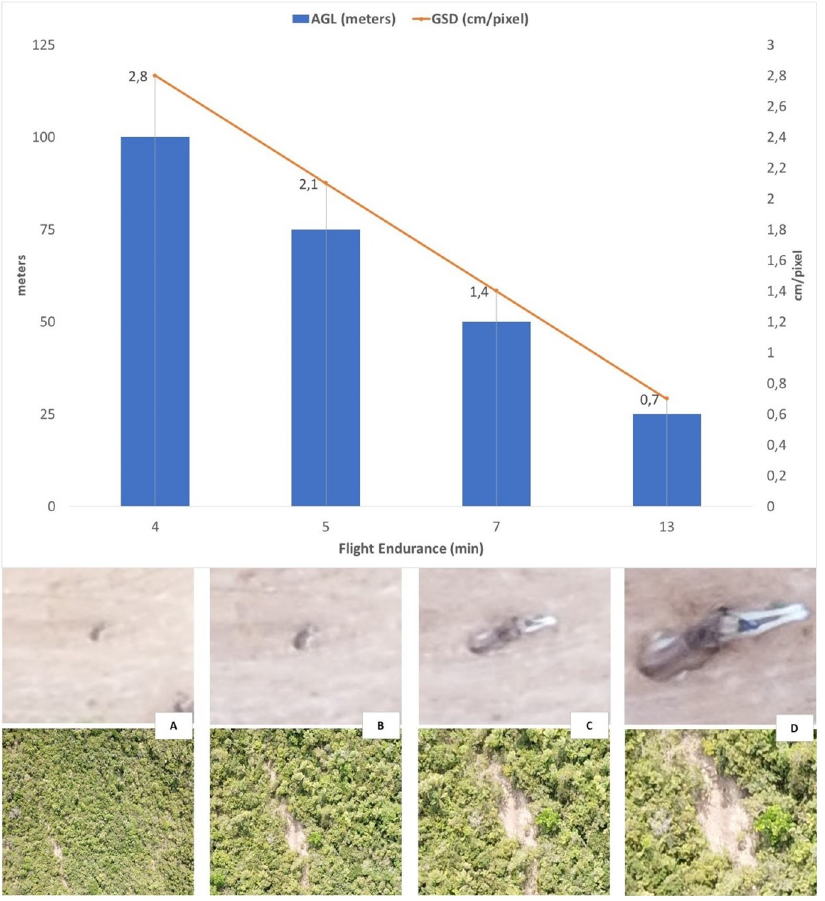
Fig 5. Comparison between Above Ground Level (AGL), Ground Sample Distance (GSD) and flight duration. Images with a 10x zoom of a dog and a deforestation spot at (a) 100 m; (b) 75 m; (c) 50 m; and (d) 25 m